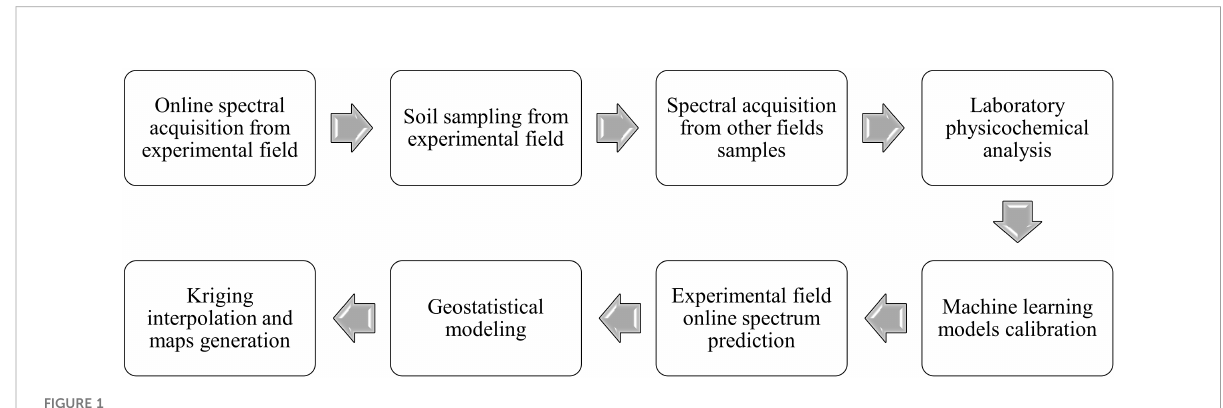
FIGURE 1 Flowchart of steps developed in this